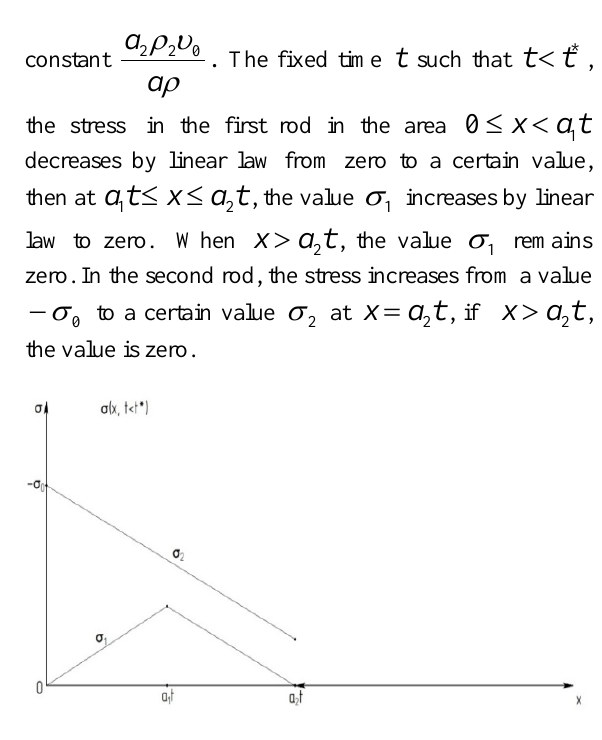
Fig. 9a. Dependence of the stresses on the coordinate. = When tax 2